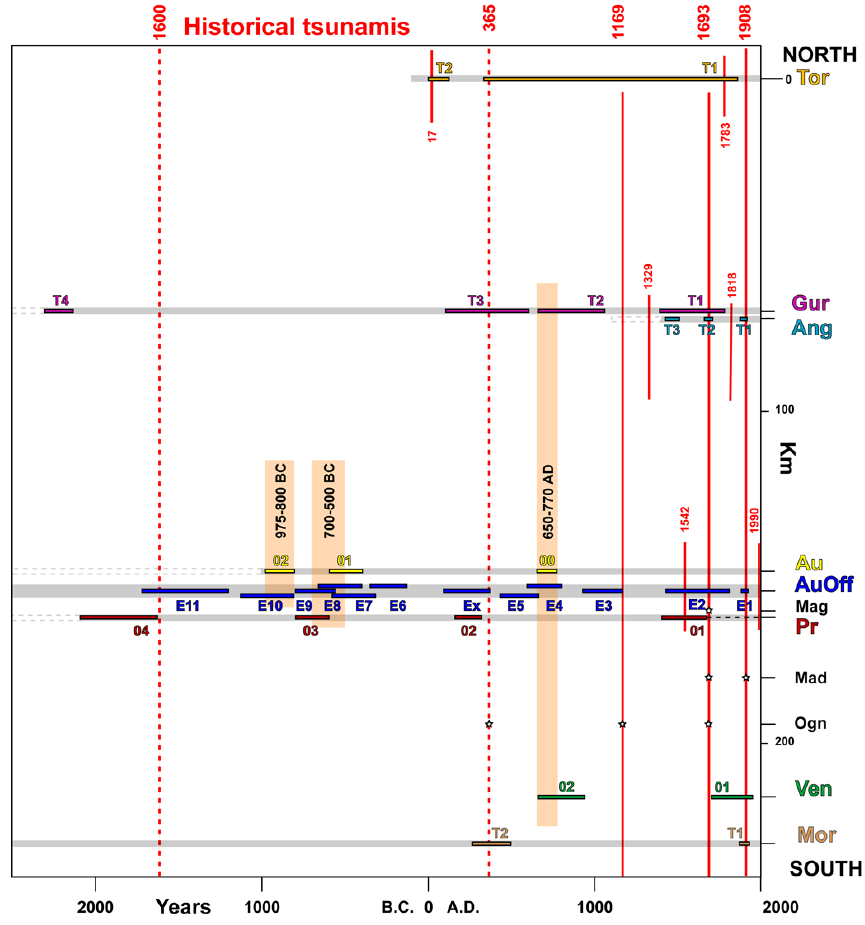
Fig. 6. Space-time plot of the tsunamis identified along the coast of eastern Sicily. The distance (km) from the northern tip to the southern one of the rectified coastline is on the y-axis, while time (years) is on the x-axis. The eight sites investigated by our group (Tor = Torre degli Inglesi; Gur = Gurna; Ang = Anguillara; Au = Augusta; AuOff = Augusta Offshore; Pr = Priolo; Ven = Vendicari; Mor = Morghella) are shown with different colours while the three sites (Mag = Magnisi P.; Mad = Maddalena P.; Ogn = Ognina) studied by Scicchitano et al. (2007, 2010) are shown in black. The horizontal coloured bars are the age intervals of the tsunamis (Scicchitano et al., 2007, 2010 events are marked with a star); horizontal light gray bars represent the time interval investigated at each site, it is dashed when extrapolated (note that for the Vendicari site results derive from boulders). Historical tsunamis dates are plotted with vertical red lines proportional to the known inundation extent along the coast (dashed when inundation sites are unknown, e.g., 365AD tsunami), while vertical hazel bars show the hypothesized best fitting age ranges for unknown